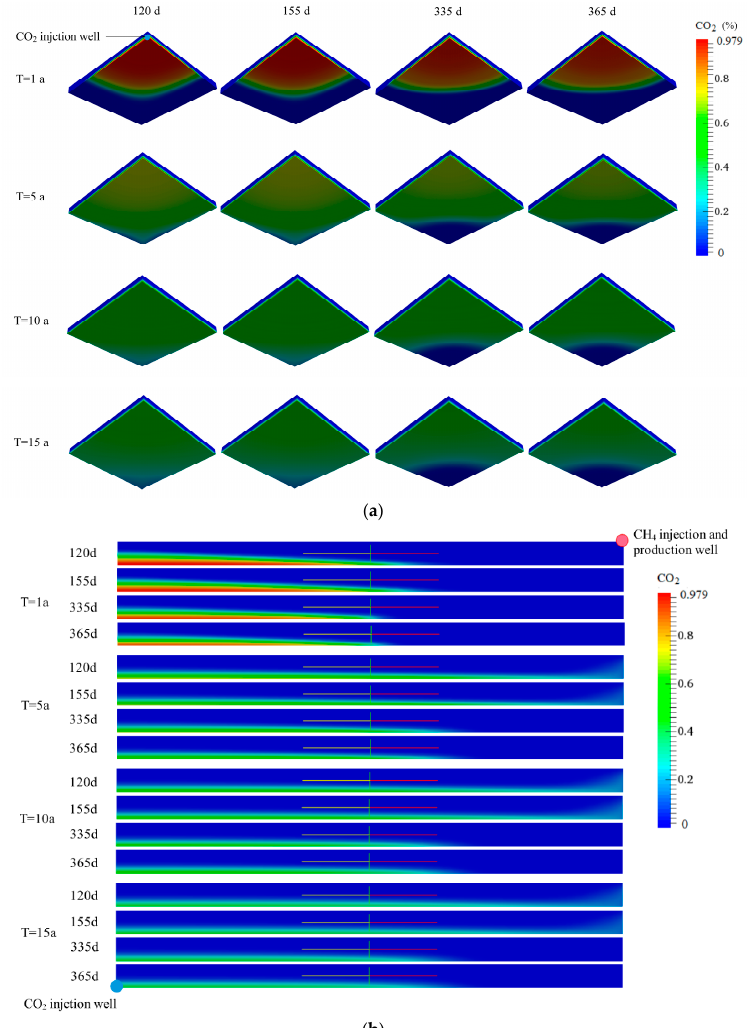
Figure 5. ( a ) CO 2 saturation in the gas phase in the 3D model and ( b ) CO 2 saturation in the gas phase in the diagonal section, which consists of the CO 2 injection well and the CH 4 injection and production